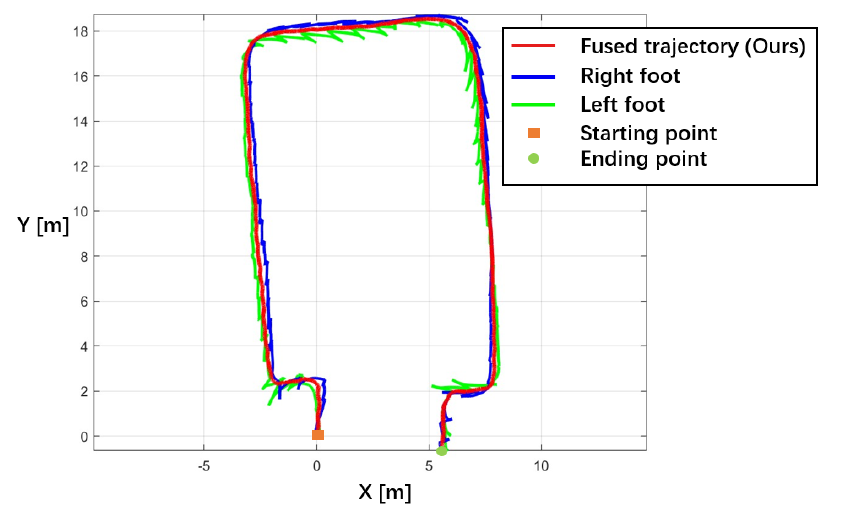
Figure 9. 2D plotting of the single foot and dual fused trajectory of Scenario 3 participant